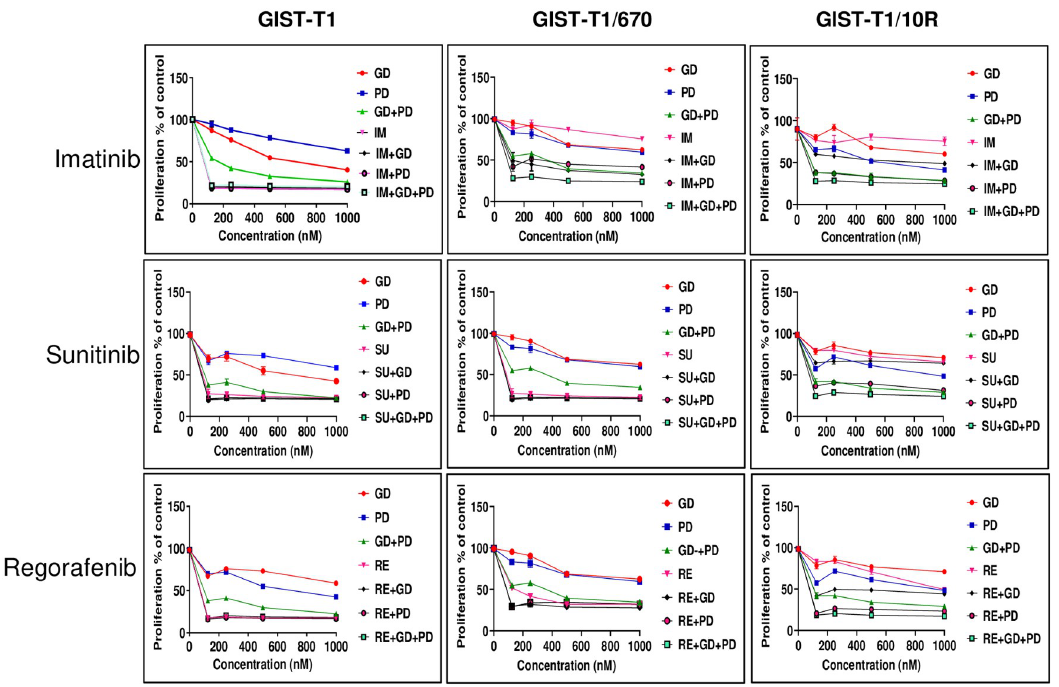
Fig 2. KIT and PI3K/MAPK Inhibitor combination significantly affects the proliferation of imatinib-resistant cell lines. Dose- response curves showing the proliferation of IM-sensitive (GIST-T1) and IM-resistant (GIST-T1/670, GIST-T1/10R) cell lines upon treatment with the indicated inhibitors. (IM: Imatinib; SU: Sunitinib, RE: Regorafenib, GD: GDC-0941, PD: PD 0325901). Cells were treated with varying concentrations of KIT inhibitors, GD and PD as indicated, PD was used at a fixed concentration of 500 nM in combination with varying doses of GD in GD+PD combination. In triple combination, GD and PD were used at a fixed dose of 500 nM with varying concentrations of KIT inhibitors. Proliferation was measured using the WST-1 reagent. Data is presented as percentage of control. Each point represents mean ± standard error, n = 3. The data is representative of three independent experiments.